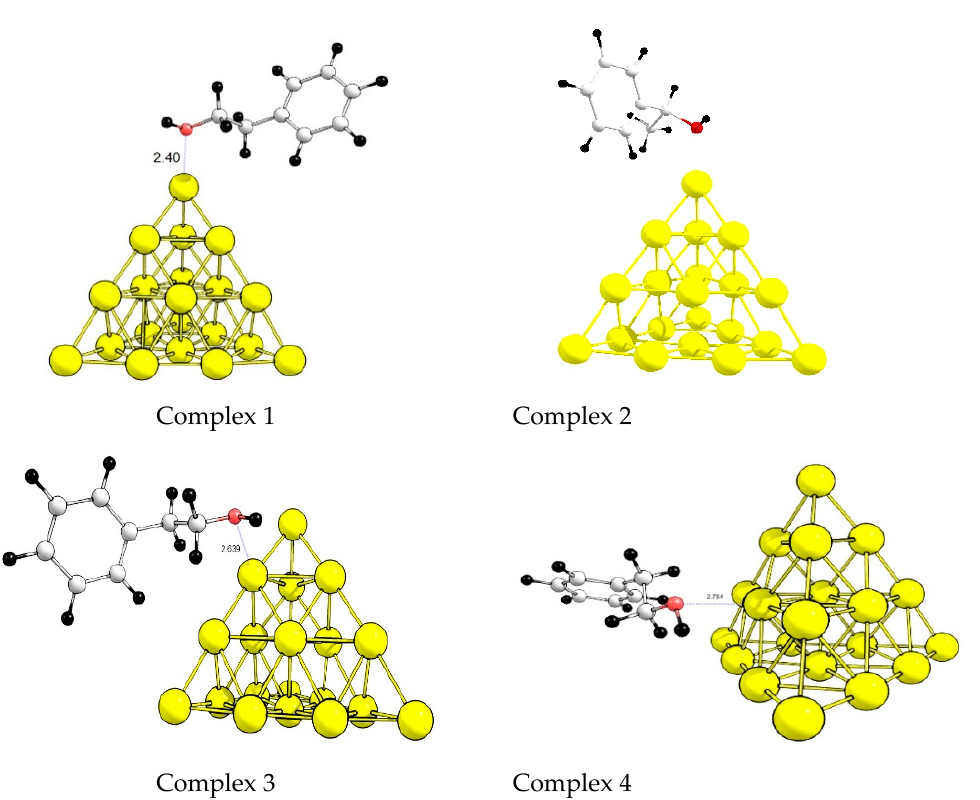
Figure 5. Optimized structures of Au 20 clusters and phenylethanol-Au 20 complexes (coordination by OH group).